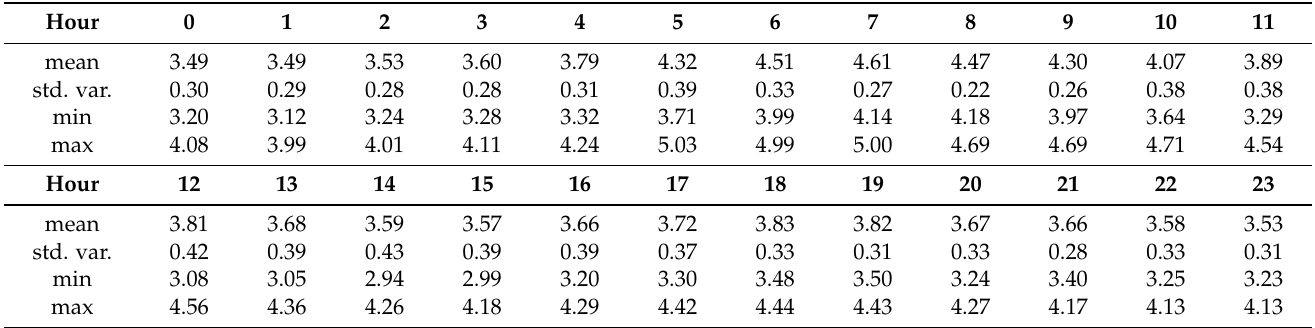
Table 2. Demand trends: the hourly trends of the heat demand, showing the mean, standard variation, minimum, and maximum values for each hour in